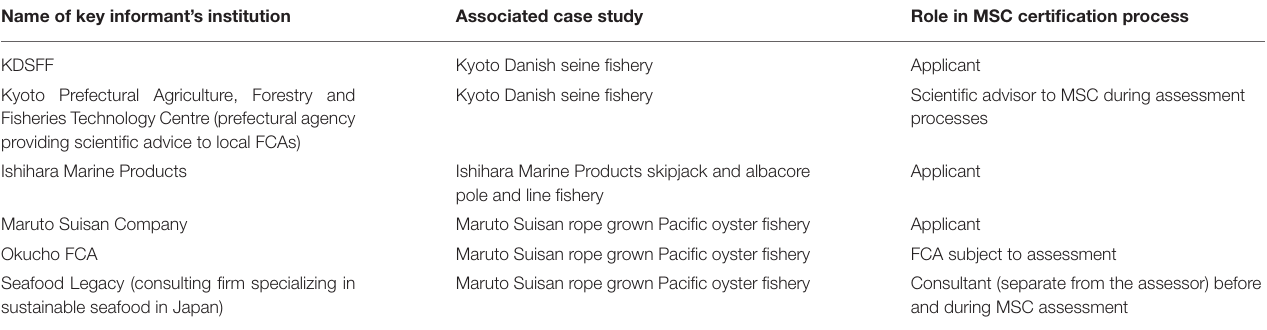
TABLE 2 | Details of key informants interviewed for each case study and their role within the MSC certification process. Name of key informant’s